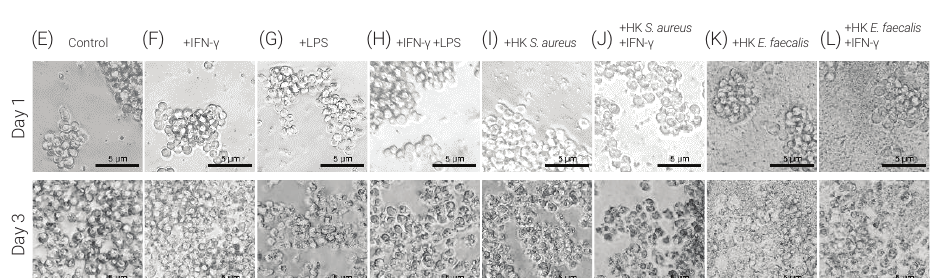
Figure 1. RAW 264.7 cell viability. Graphs represent cell cultures with different concentrations (10 5 -10 8 CFU.mL -1 ) of HK- S. aureus antigen (A) with rIFN-γ (C) or HK- E. faecalis antigen (B) with rIFN-γ (D), after 72h of cell incubation. Bars represent mean and standard error of cellular absorbance (595 nm) carried out in technical and biological triplicates. Statistical differences by one-way ANOVA test and Bonferroni post hoc were represented by * (p < 0.05), ** (p < 0.01) and *** (p< 0.001). Optical microscopy (20x) shows the initial (day 1) and final (day 3) cell morphology aspects (E-K) of RAW 264.7 stimulated with rIFN-γ (F), LPS (G), LPS and rIFN-γ (H), HK- S. aureus 10 6 CFUs without (I) or with rIFN-γ (J), HK- E. faecalis 10 6 CFUs without (K) or with rIFN-γ (L) compared to the cell control group